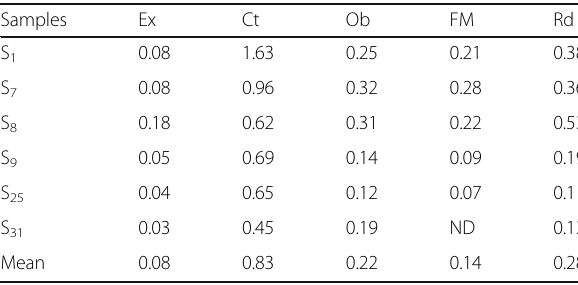
Table 4 Cadmium fractionation results (ppm)